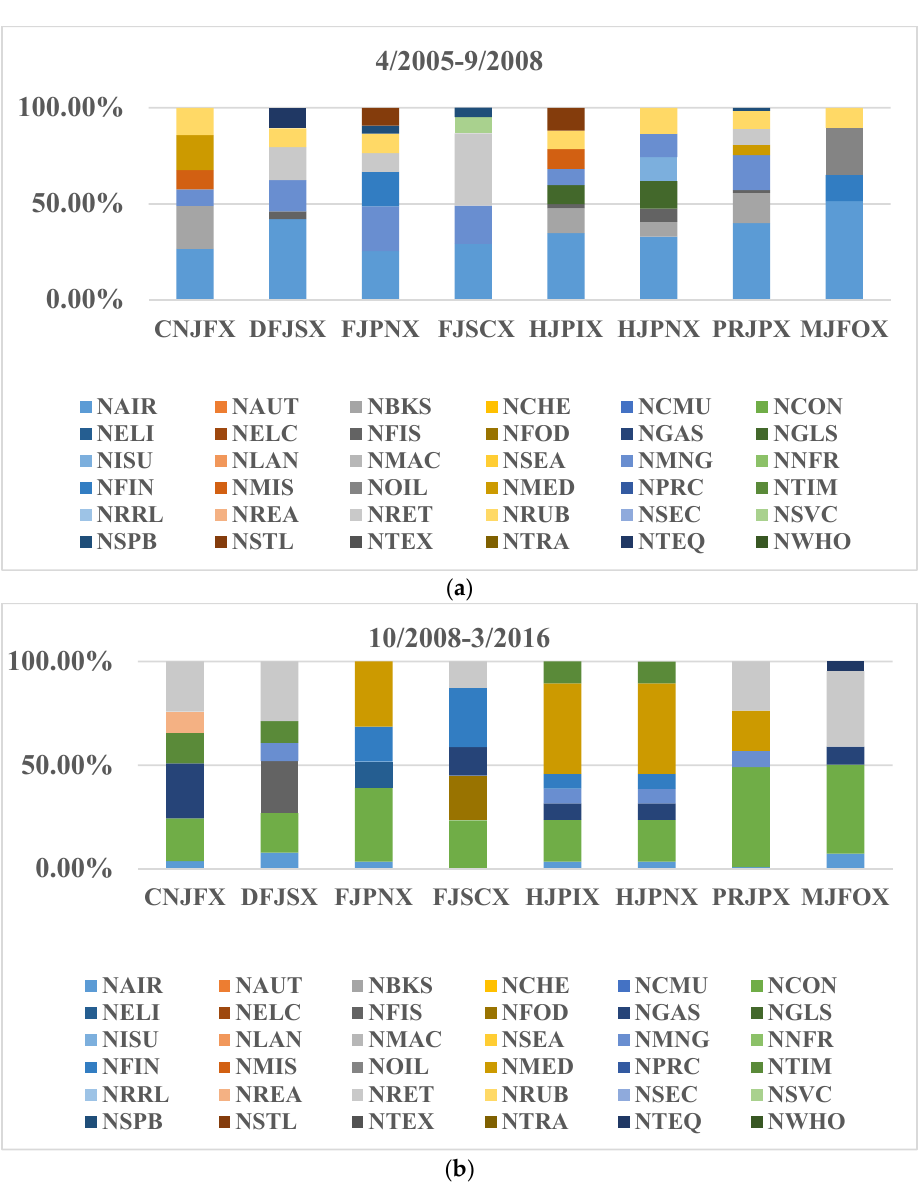
Figure 10. Mutual finds’ exposure to Japanese sectors before and after the 2008 crisis. (a) Percentages of exposures of each mutual fund to each Japanese sector before the Lehman Brothers default; (b) Percentages of exposures of each mutual fund to each Japanese sector after the Lehman Brothers default.